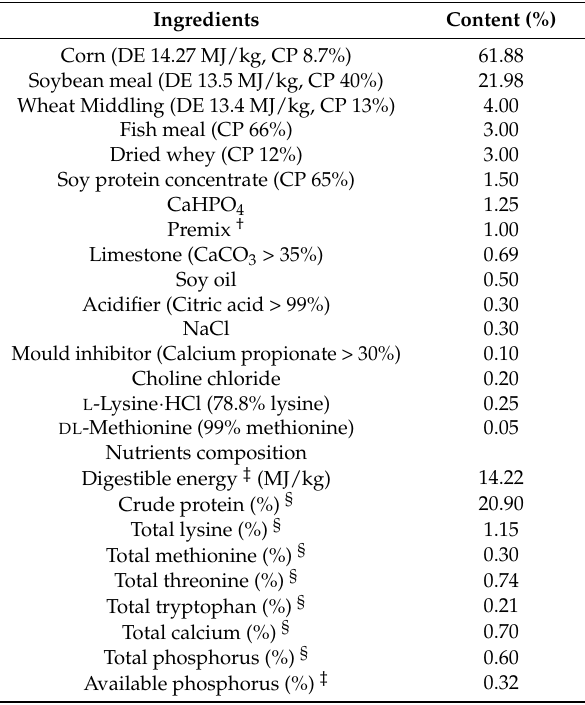
Table 6. Composition and nutrient contents of the basal diet (as-fed